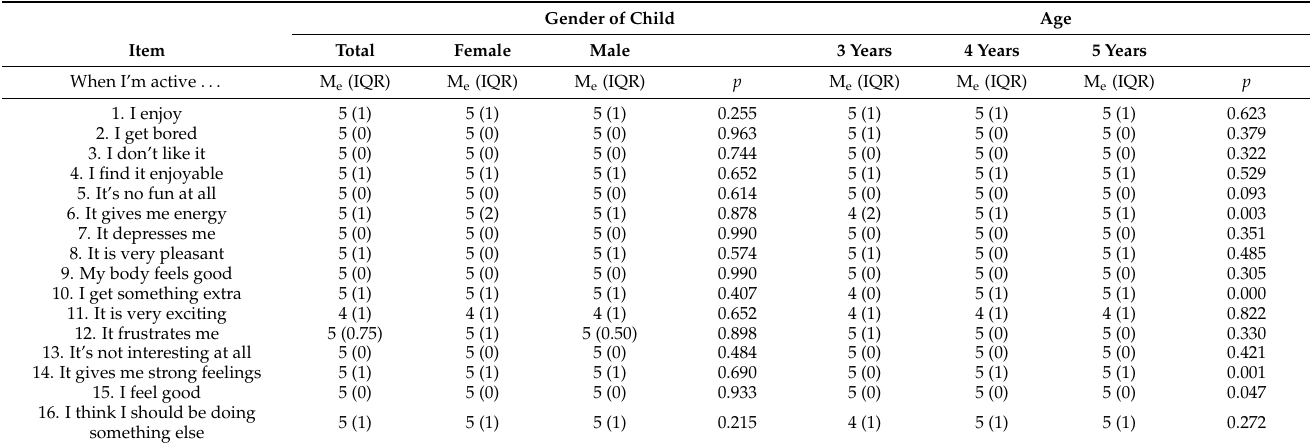
Table 3. Descriptive analysis and variations in the parent questionnaire items according to gender and age.